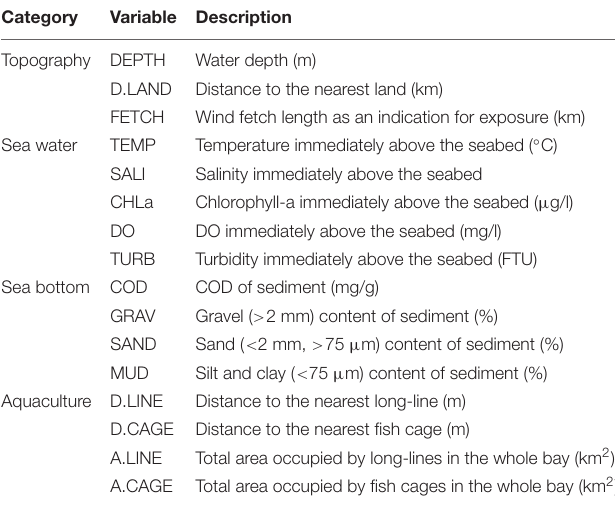
TABLE 1 | Description of environmental variables used in this study.